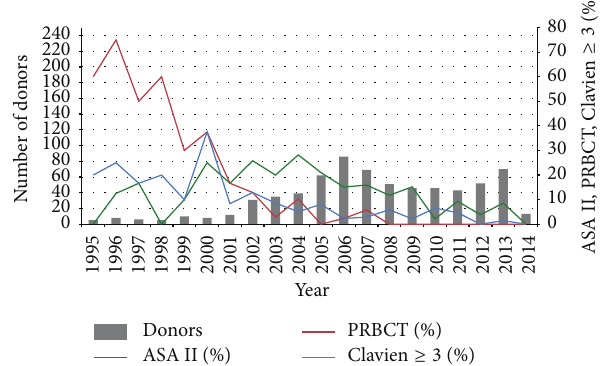
Figure 1: Distribution of donor operations, use of PRBCT, preva- lence of ASA II donors, and prevalence of complications ≥ grade III of the Clavien-Dindo classification, from 1995 to 2013. ASA: American Society of Anesthesiology classification; PRBCT: packed red blood cell